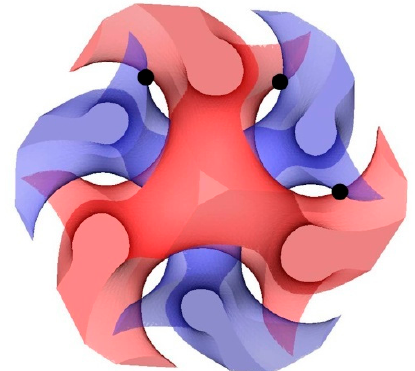
Figure 6. Schematic illustration of the two asymmetric networks of PI (blue color) and PB (red color) in PS matrix (white). The networks are inflated in order to reach the corresponding volume fractions of 0.23 and 0.31, respectively for the PI and PB segments. The black dots in the scheme indicate the possible junction point location of the ABC miktoarm terpolymer. Table 3. Permitted and experimentally observed reflections of the I4 1 32 cubic space group (according to International Tables of Crystallography). Comparison with the permitted reflections of 𝑃𝑛3(cid:3364)𝑚 (OBDD) and 𝐼𝑎3(cid:3364)𝑑 (DG).